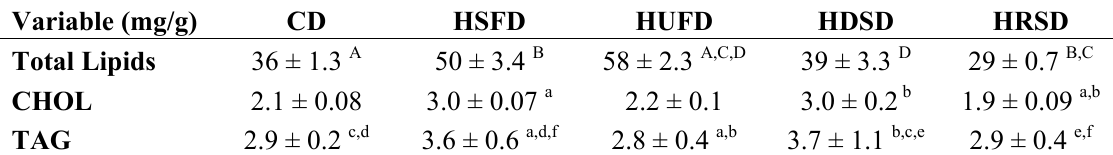
Table 5. Effects of experimental diets on hepatic